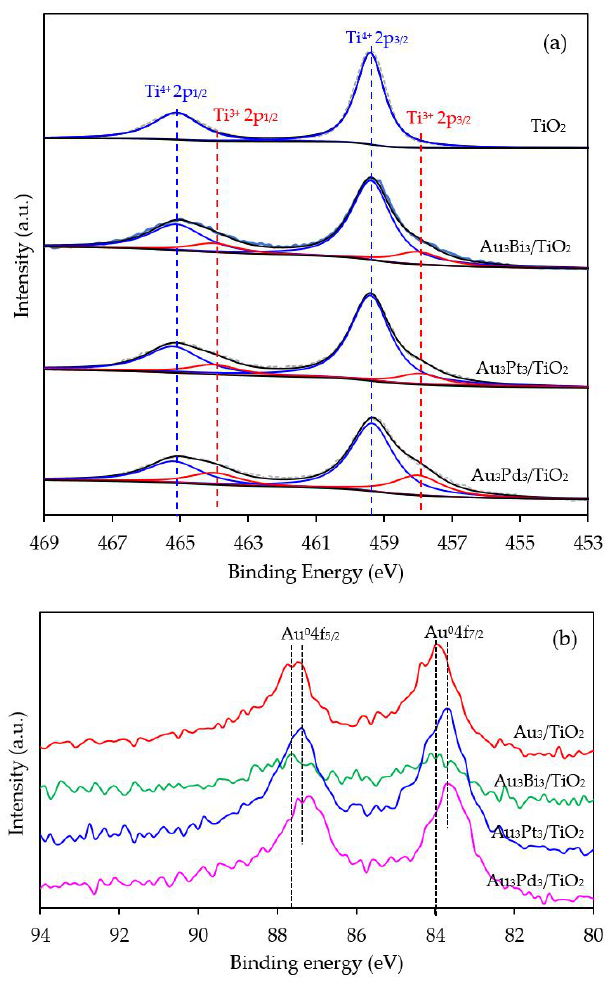
Figure 11. Representative HR-XPS spectra of ( a ) Ti2p and ( b ) Au4f of the TiO 2 , Au 3 /TiO 2 and the different Au 3 M 3 /TiO 2 photocatalysts.